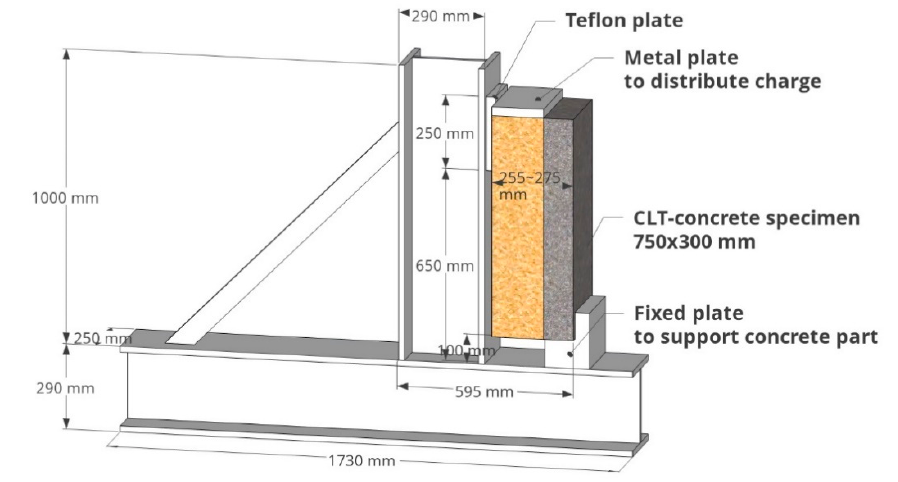
Figure 3. Adaptor for the asymmetrical CLT-concrete specimen.